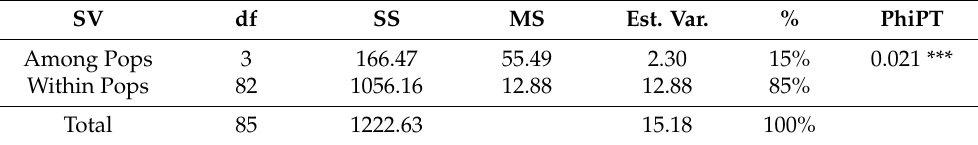
Table 5. Analysis of molecular variance (AMOVA) of 80 potato genotypes based on 11 iPBS markers presenting the percentage of molecular variance among and within the